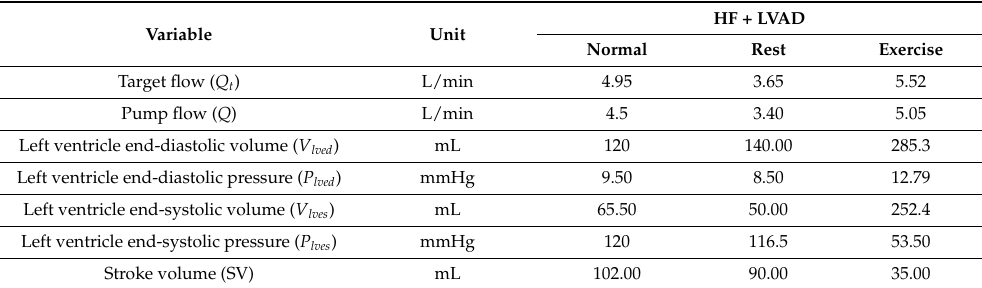
Figure 5. Hemodynamic variable results in the exercise condition; ( a ) pressure–volume loops; ( b ) pump speed; ( c ) estimated flow vs. target pump flow; ( d ) pump flow pulsatility vs. estimated flow. Table 2. Hemodynamic data of the model for both healthy and heart failure